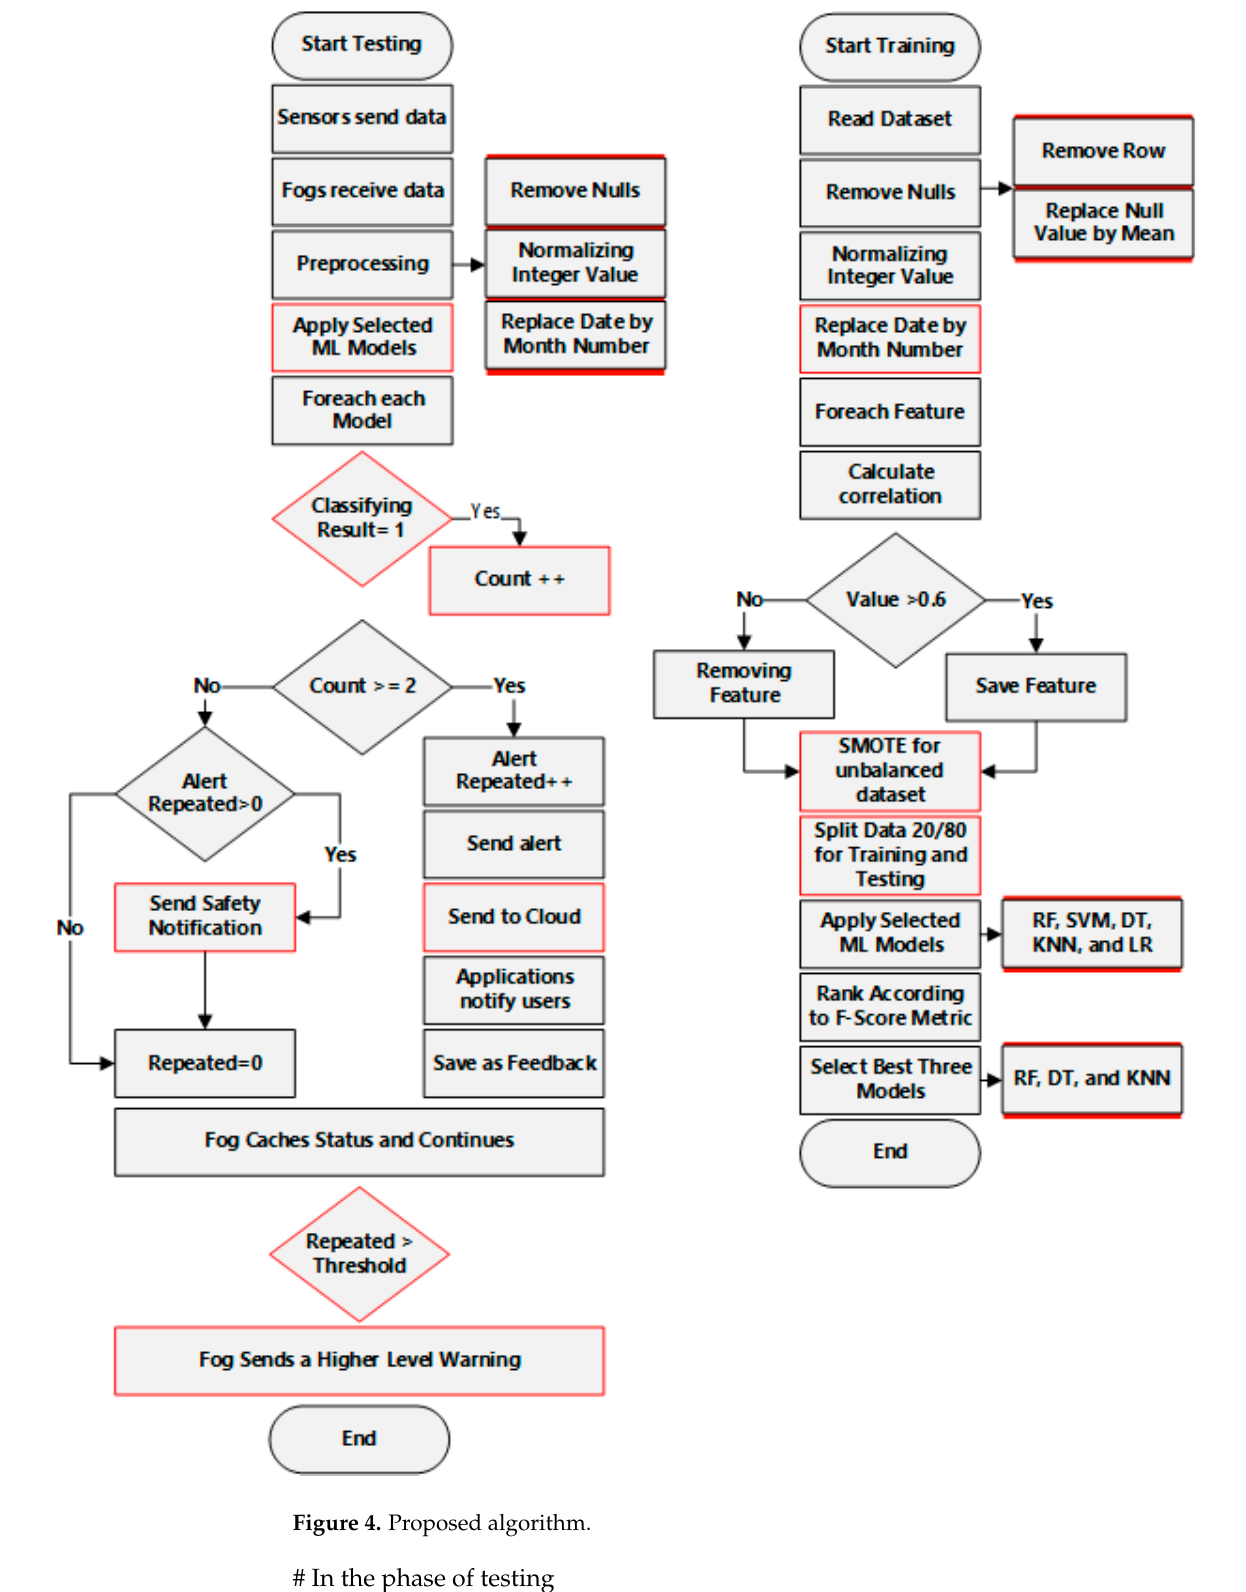
Figure 4. Proposed algorithm.